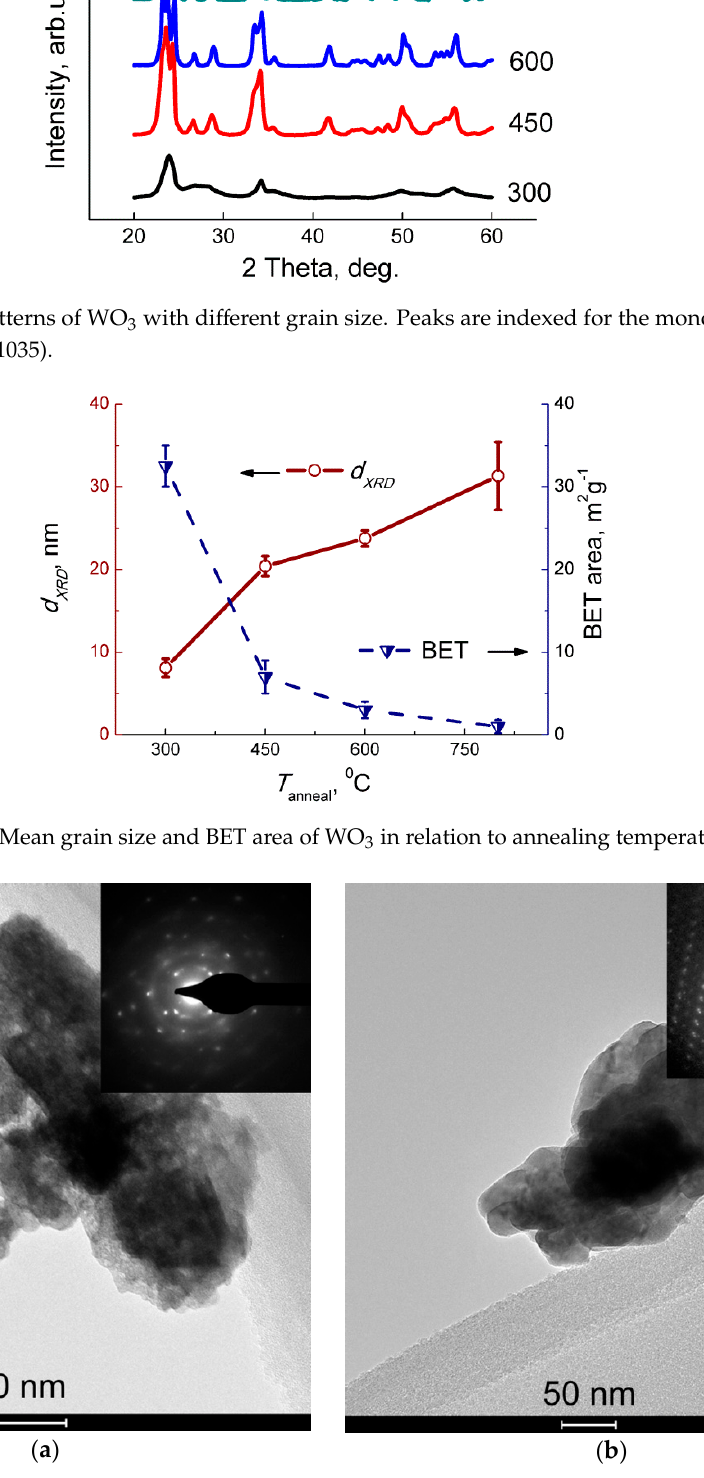
Figure 3. TEM images of WO 3 samples annealed at 300 ° С ( a ) and 450 ° С ( b ). The insets show electron diffraction patterns.